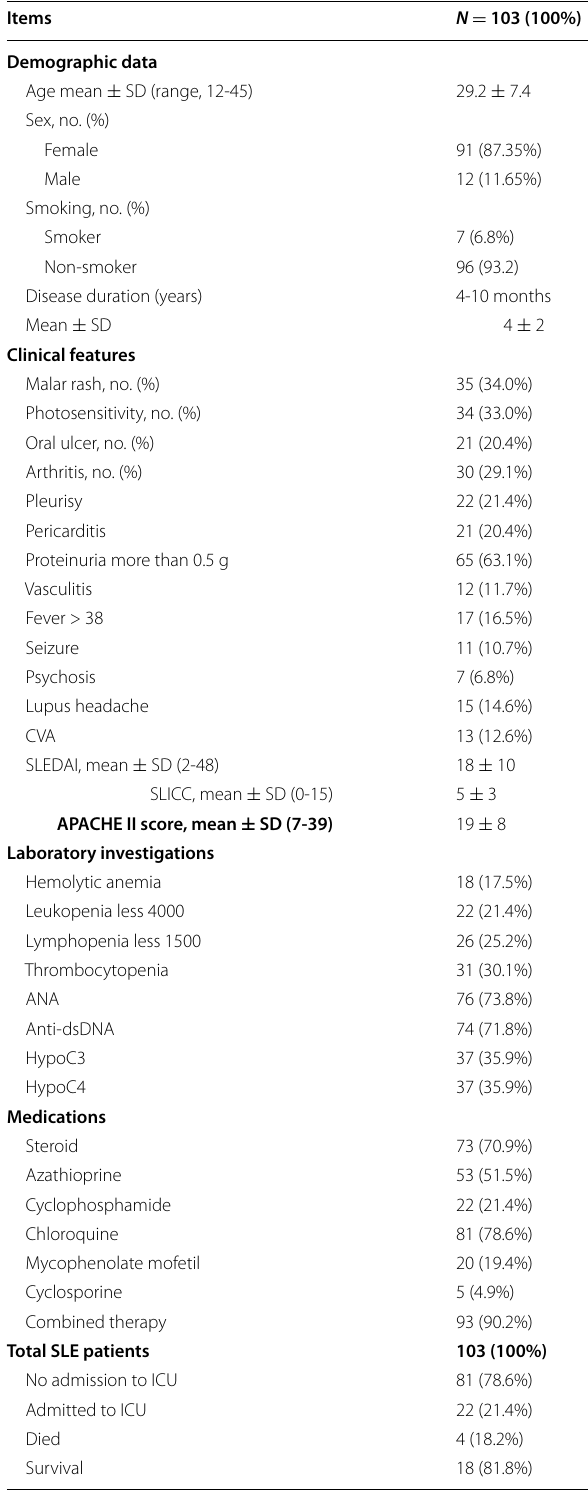
Table 1 The demographic, clinical, and laboratory data of the study group of 103 SLE